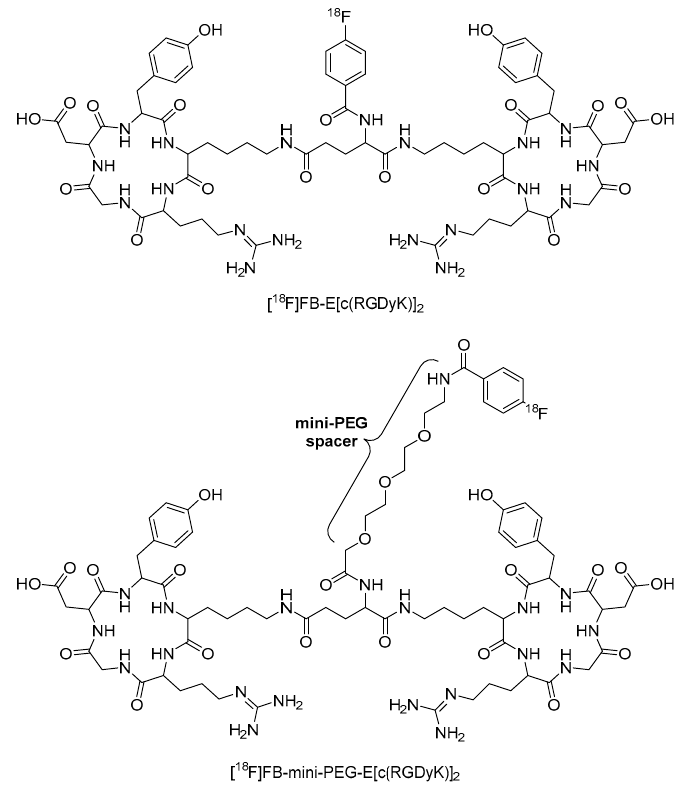
Figure 18. Structures of [ 18 F]FB-E[c(RGDyK)]